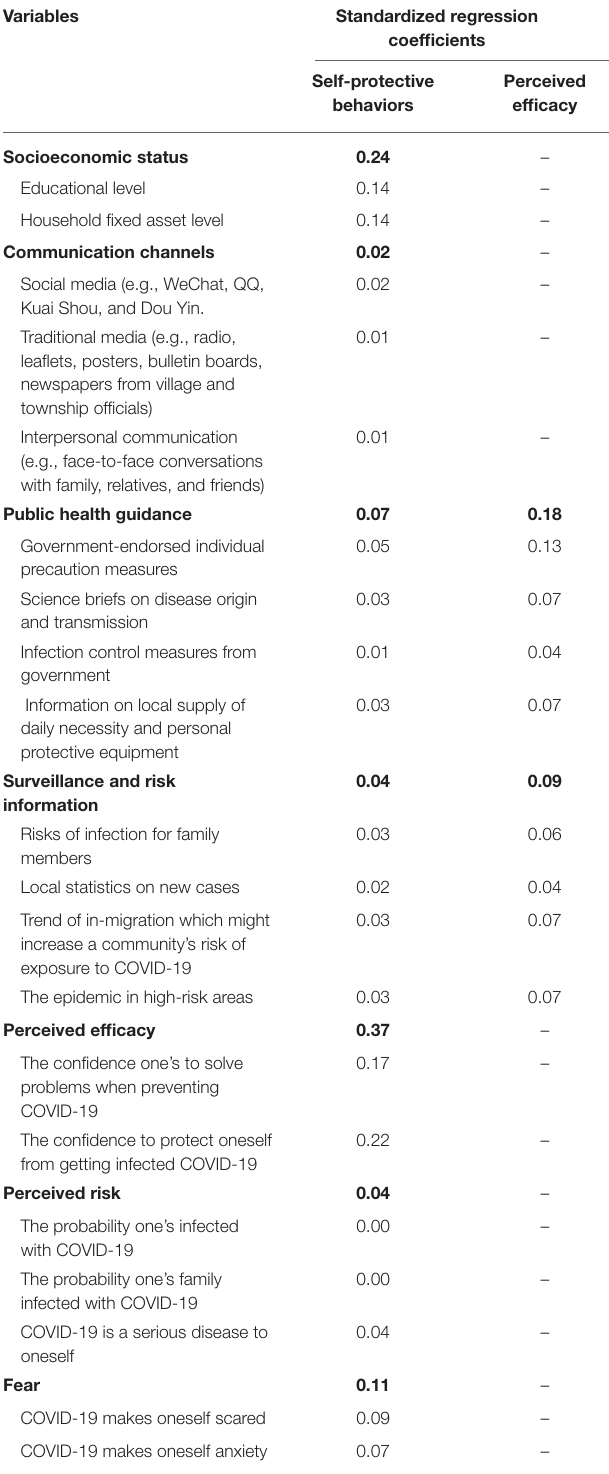
TABLE 3 | Relationship of the measured variables, latent variables with self-protective behaviors and perceived efficacy in response to COVID-19 among women in rural western China ( N =